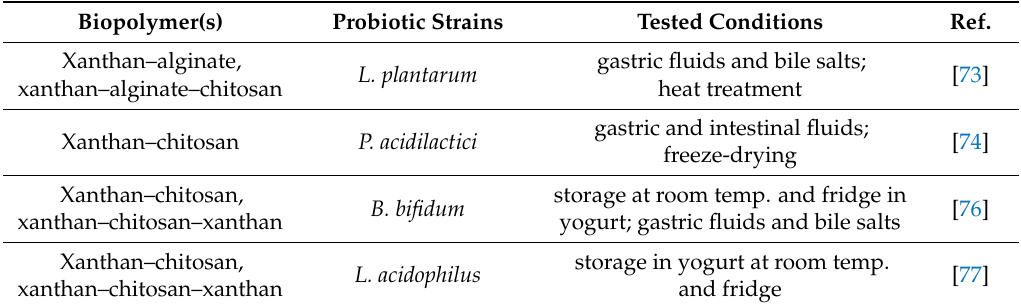
Table 3. Xanthan-based hydrogels used as delivery systems of selected probiotic